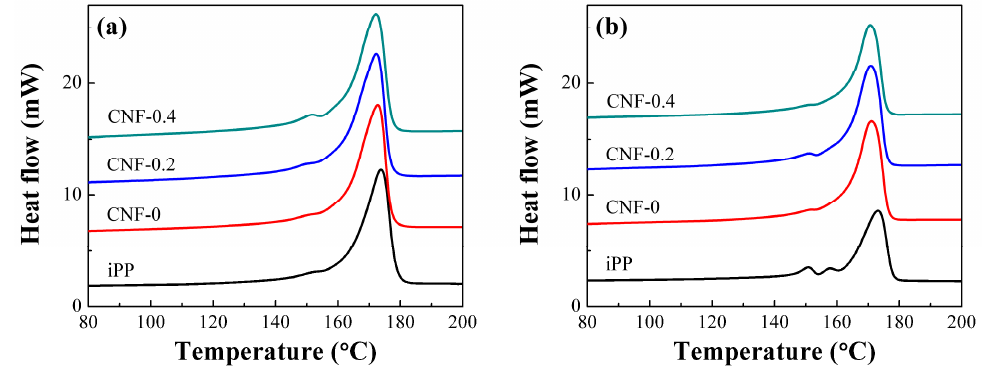
Figure 8. The first heating curves of the core region for: ( a ) solid, and ( b ), 2-fold foamed iPP and PP/CNF nanocomposites.